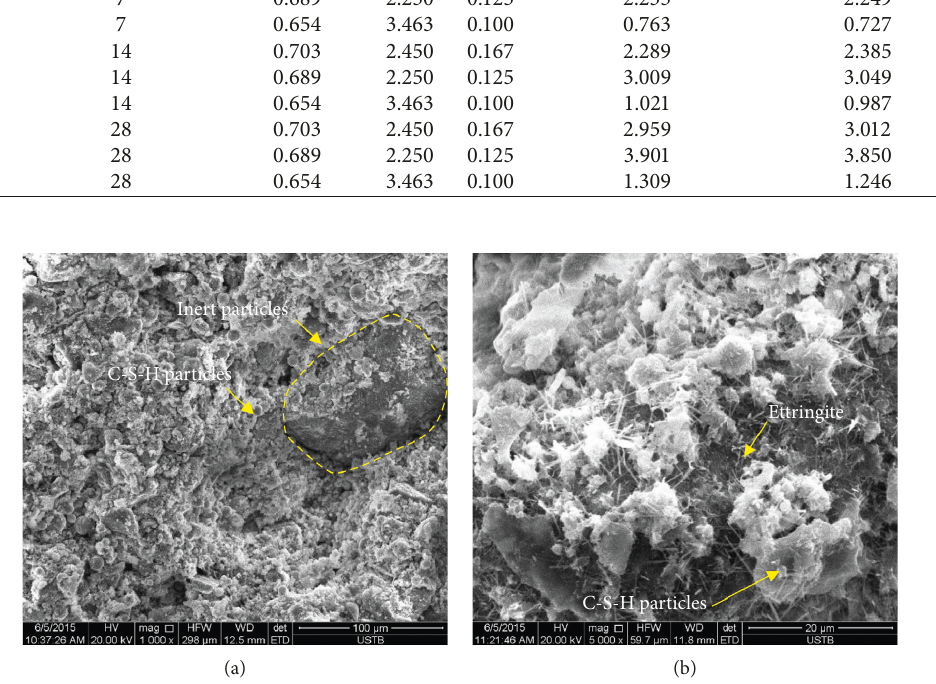
Figure 8: Microstructural images of waste-unclassified tailings paste. (a) Microcosmic image 1000x. (b) Microcosmic image